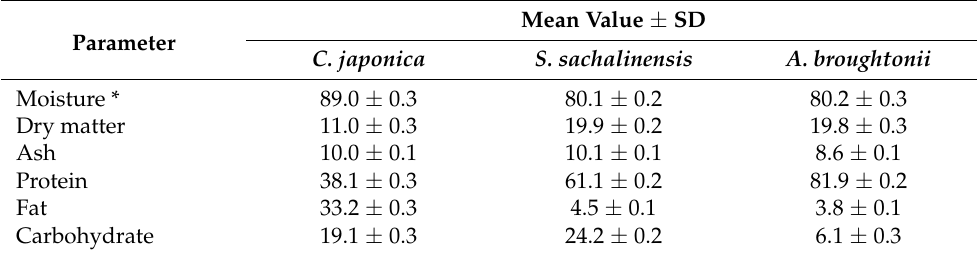
Table 1. Proximate composition of muscle tissue of bivalve mollusks (%).